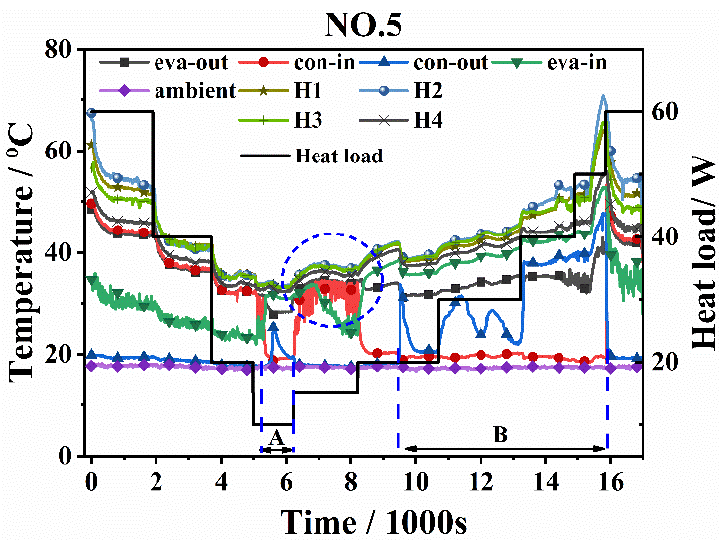
Figure 15. Temperature response during continuous operation of No.5 position at 60 W-10 W-60 W.